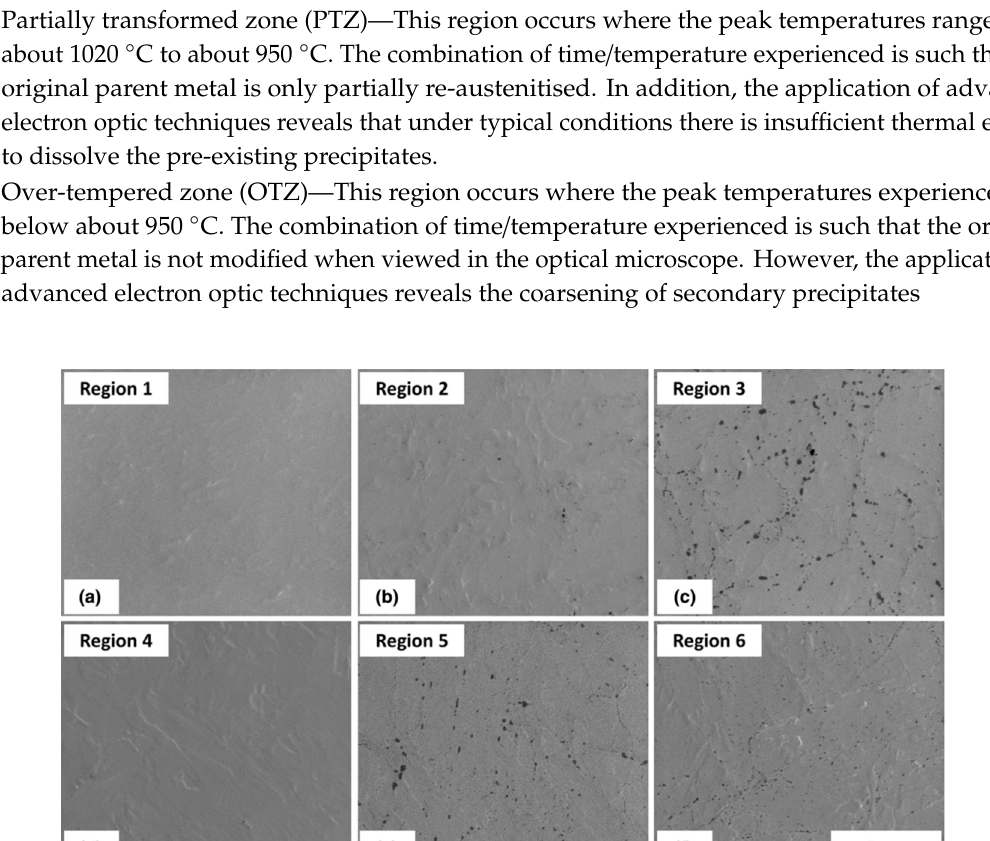
Figure 8. Example of Feature Creep Tests Used in the Evaluation of Damage in the Heat Affected Zone of Grade 91 Steel. Note: the feature test sample contains the entirely of the weld, the HAZ on both sides of the weld and sufficient base metal to promote stress states in the weldment.